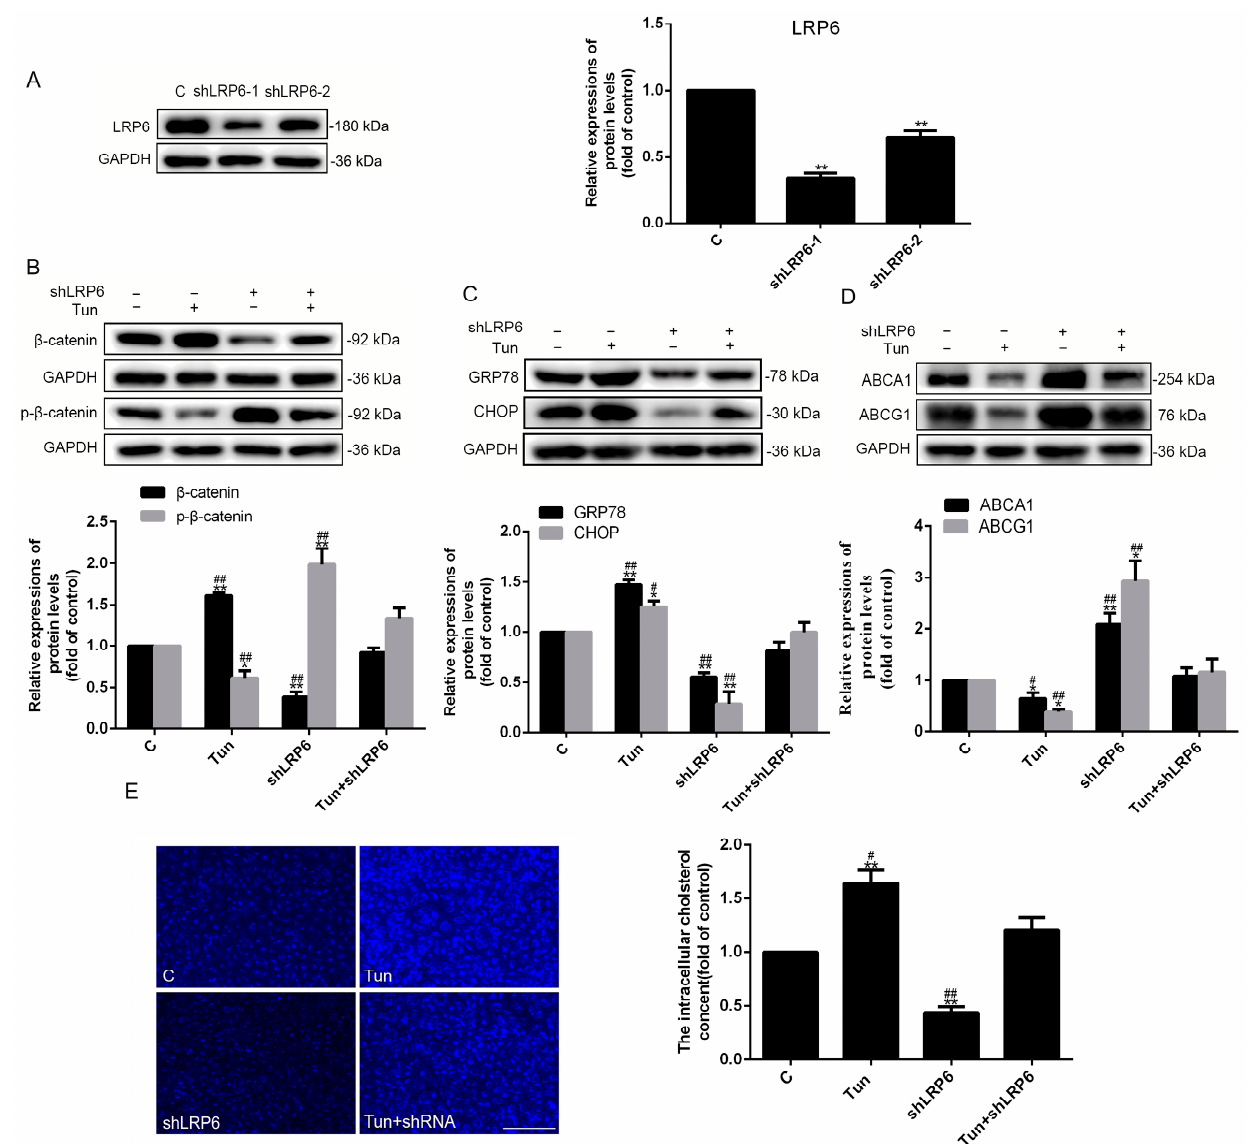
Figure 8. Suppressing the Wnt/ β -catenin signaling pathway by knocking down LRP6 specifically has the same functions as salinomycin, that is, inhibiting ER stress and lowering cholesterol accumulation. ( A – D ) The expressions of GRP78, CHOP, β -catenin, and p- β -catenin ABCA1 and ABCG1 were detected by Western blot. ( E ) Filipin staining detected the intracellular cholesterol of HUVECs, 10× magni fi cation. n = 3, * p < 0.05 and ** p < 0.001 vs. the C group; # p < 0.05 and ## p < 0.001 vs. the Tun + shLRP6 group. C, control group (treated by DMSO); Tun, cells treated with tunicamycin (10 µmol/L) for 24 h; shLRP6, cells were infected with lentivirus containing LRP6-speci fi c knockout for 48 h; Tun + shLRP6, cells were continuously treated with tunicamycin (10 µmol/L) for 24 h after transfection with lentivirus containing LRP6-speci fi c knockout for 48 h. The scale of the images is 100 µm.